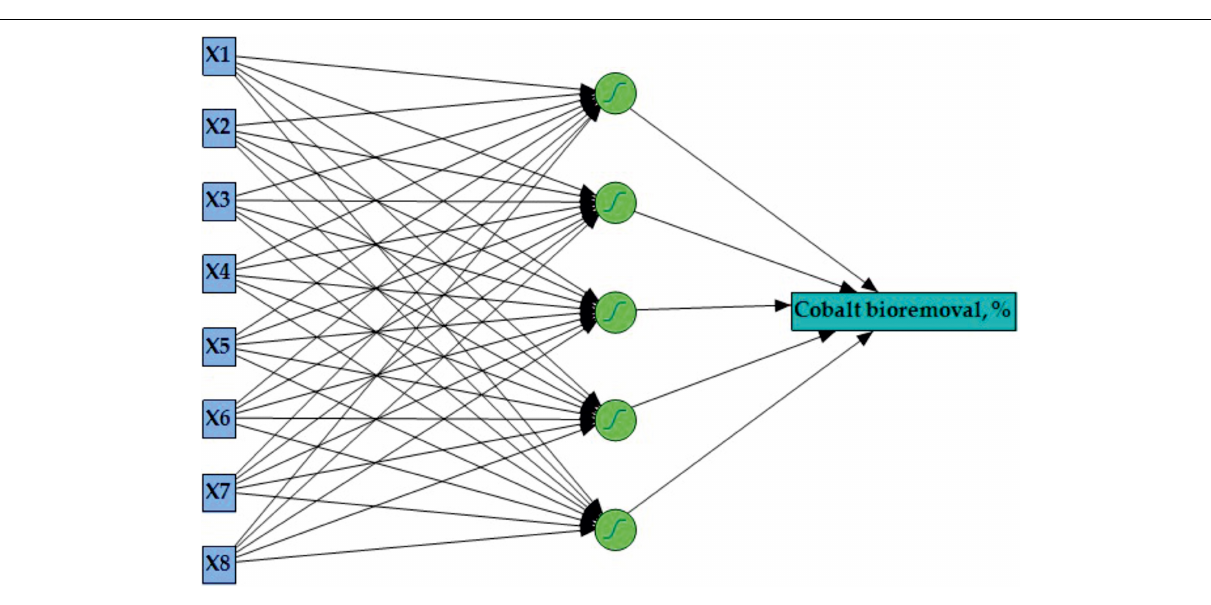
FIGURE 3 | The general layout of the proposed artificial neural network for cobalt bioremoval by P. alcaliphila shows an input layer with eight neurons, a hidden layer with five neurons, and an output layer with one neuron. X1, pH; X2, incubation time (h); X3, initial CoSO 4 .7H 2 O (ppm); X4, glucose (%); X5, glycerol (%); X6, peptone (%); X7, K 2 HPO 4 (%); and X8, MgSO 4 .7H 2 O